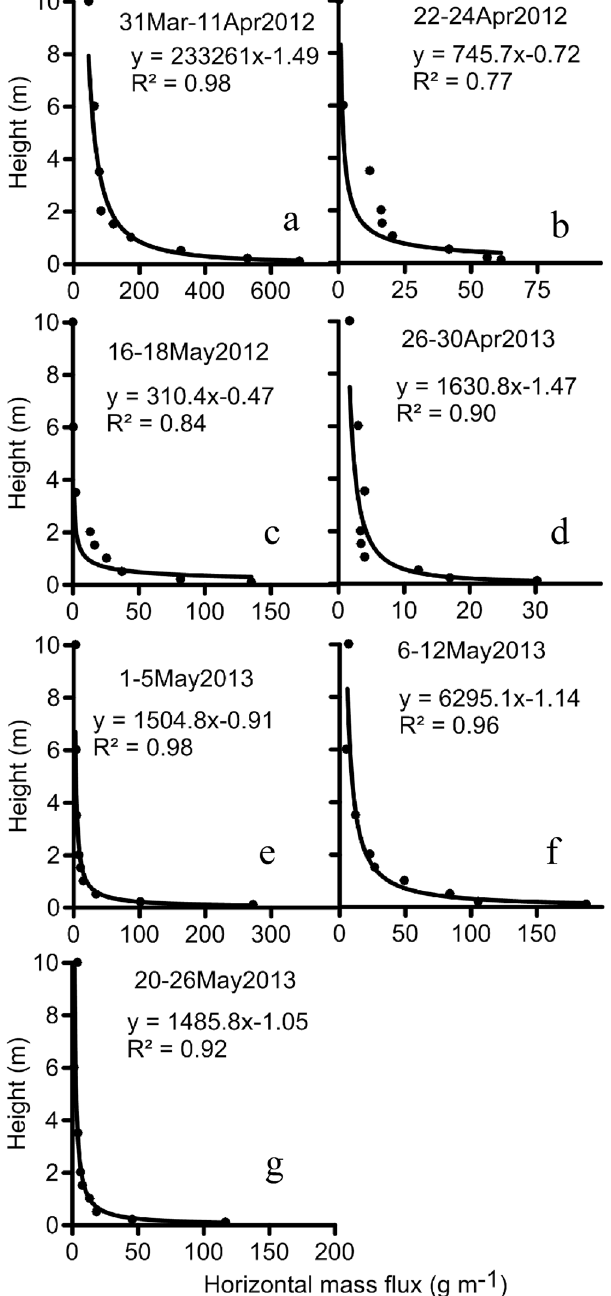
Figure 2. Horizontal mass flux as a function of height above the eroding surface during seven high wind events. Sediment was trapped by BSNE collectors positioned at nine heights (0.1–10